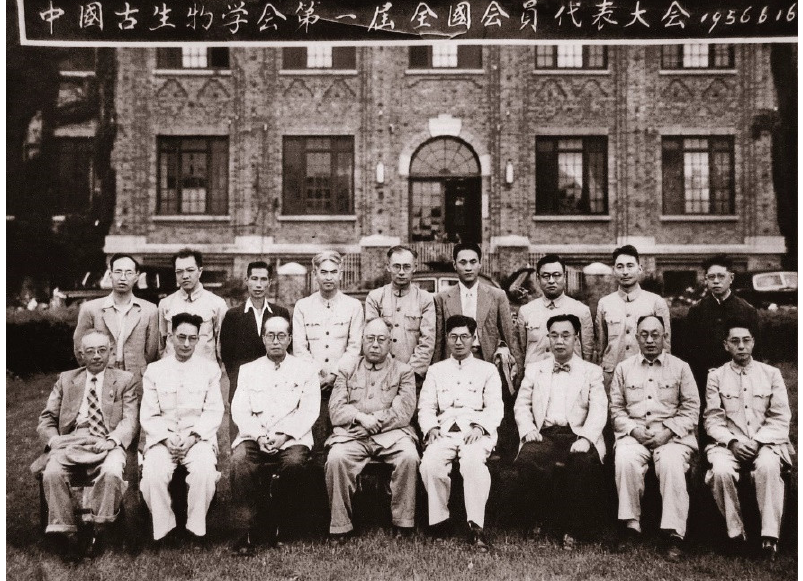
Figure 4. Group photo of officials elected at the first National Congress of the Chinese Paleontological Society in 1956. Front row, front the left: Senxun Yue, Zanxun Yin, Xiaohe Zhou, Zhongjian Yang, Yunzhu Sun, Xingjian Si, Jinke Zhao, and Zunyi Yang. Back row, from the left: Hongzhen Wang, Zhiwei Gu, Yuanren Qu, Shicheng Huo, Ren Xu, Minzhen Zhou, Yu Wang, Enzhi Mu, and Longqing Chang (credit to NIGPAS). The Chinese characters means the photo was taken at the first National Congress of the Chinese Paleontological Society on June 16 th , 1956.